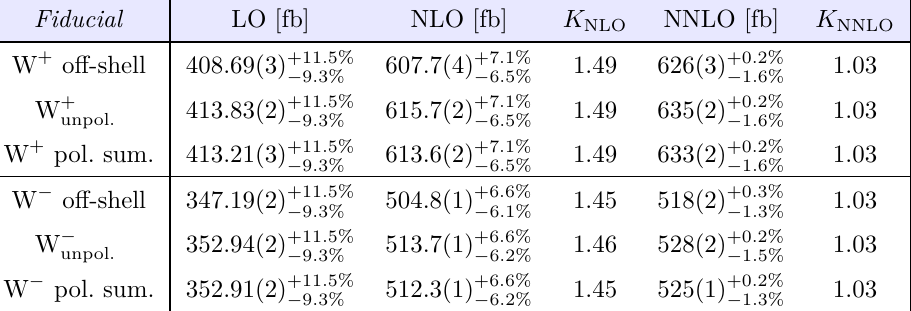
Table 4 . Total cross sections of pp → ‘ ± ( − ) ν ‘ j for the fiducial setup at the LHC with a centre of √ mass of s = 13 TeV. The unpolarised and polarised-sum predictions are provided at LO, NLO, and NNLO accuracy as well as with the corresponding K -factors. All cross sections are expressed in fb. The numbers in parenthesis indicate the numerical error while the ones in per cent represent 7-scale